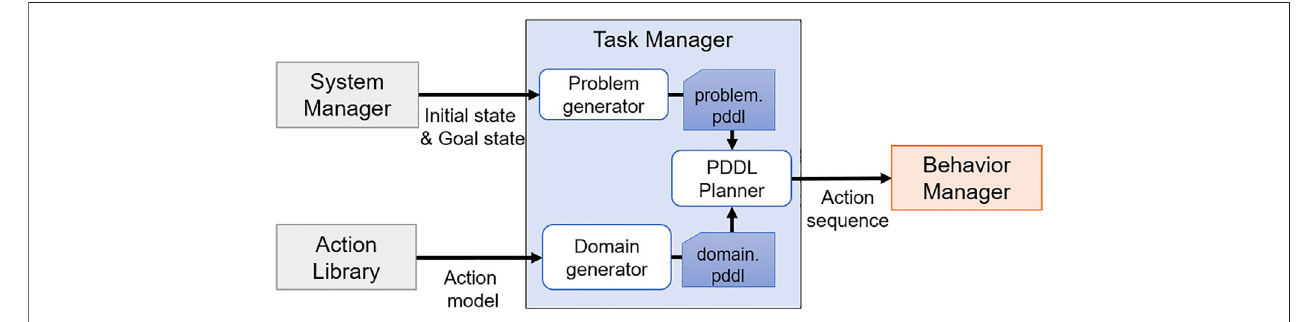
FIGURE 4 | Diagram of the task